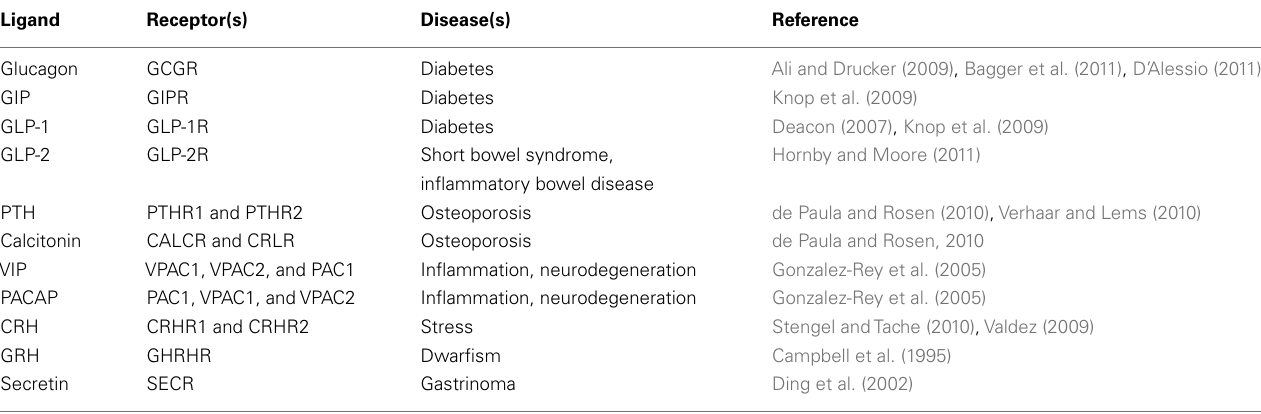
Table 1 | Potential therapeutical interests of targeting family B1 GPCRs and/or their natural ligands in human